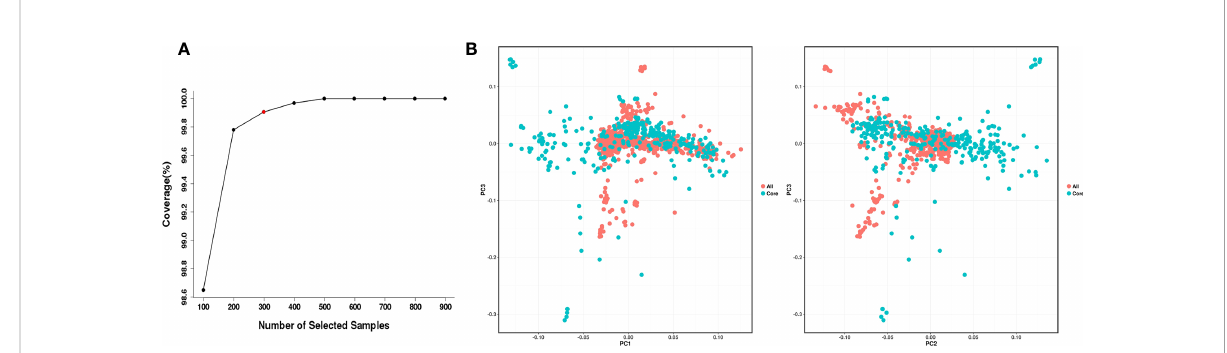
FIGURE 5 Development and evaluation of the O. ru fi pogon core collection. (A) Coverage of allelic diversity versus number of selected accessions. The red circle indicates the minimal number of samples (299) covering 99.906% allelic diversity. (B) PCA of O. ru fi pogon accessions. Red dots represent the accessions in the core collection; green dots represent the accessions not in the core collection.